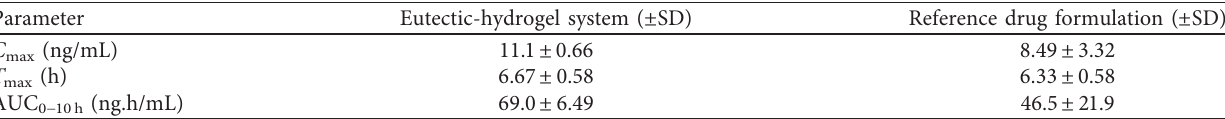
Table 3: Pharmacokinetic parameters of progesterone on rabbit models.